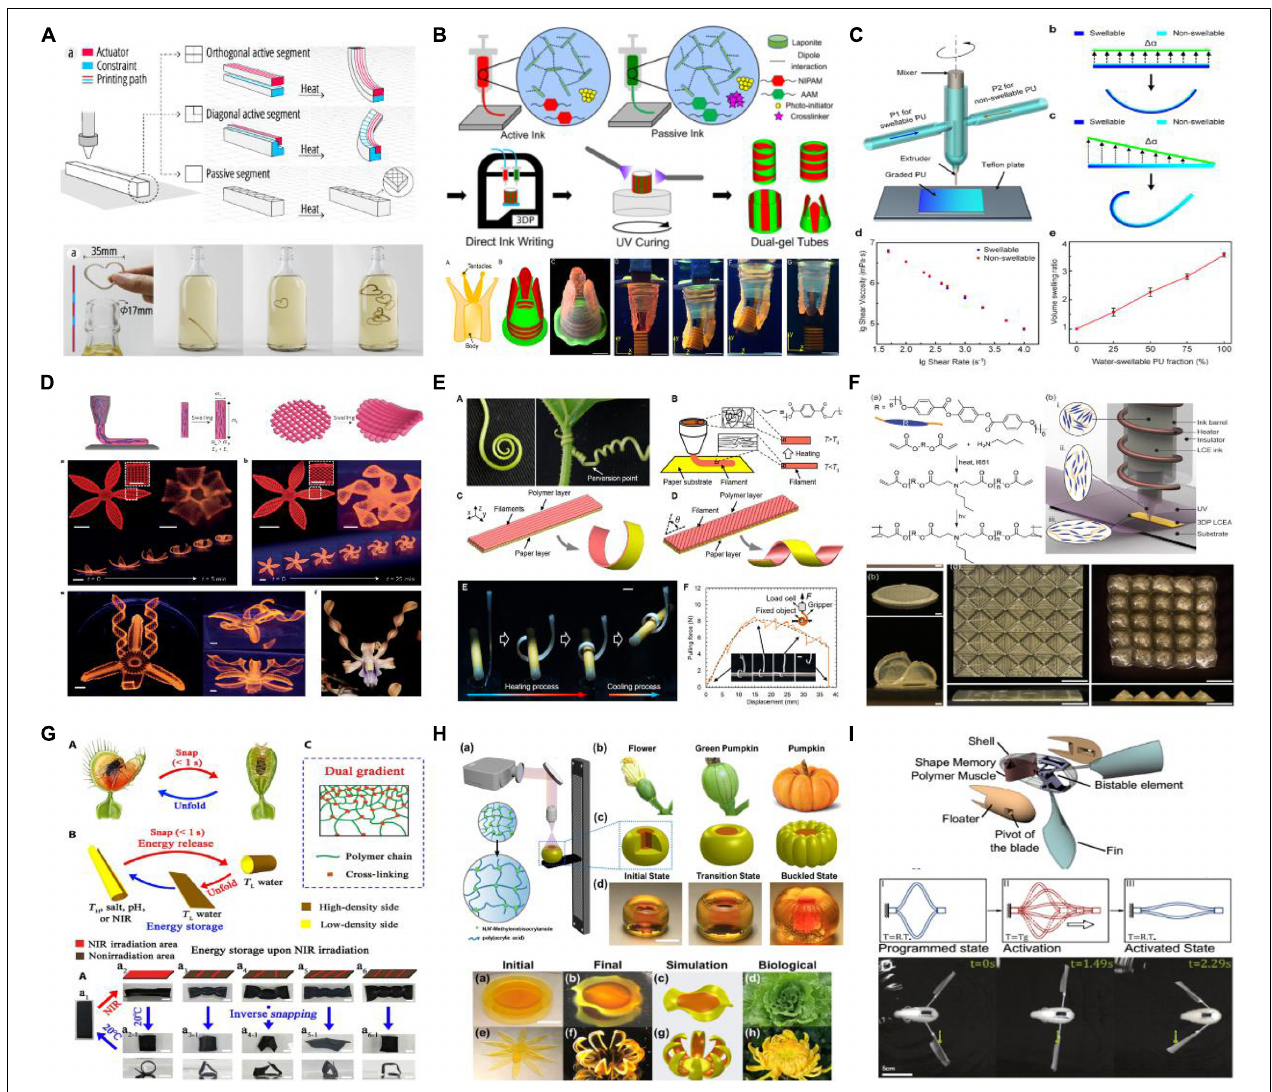
FIGURE 5 | The soft actuators by mimicking the structures of plants in nature. (A) The line-shaped deformable composite structure by arranging the local material with different thermal–mechanical properties. (B) The gel tubes with the ability of gripping by strategic placement of a swelling gel and a nonswelling gel. (C) Dual-stimulated self-deforming structures by printing graded water-responsive materials on the thermal shrinkable shape memory polymers. (D) Localized, anisotropic swelling hydrogel composites by aligning the cellulose fibrils with the inducing force generated in extrusion process. (E) Robotic tendril with anisotropic shape-morphing behaviors by tailoring a polymer–paper bilayer composite sheet with the design of print pattern. (F) Liquid crystal elastomer (LCE) soft actuators with spatially aligned nematic order by programming the print path with the shear force generated in printing process. (G) Rapid response to hydrogel sheet fracture by controlling the magnitude and location of prestored energy in the hydrogel sheet. (H) Buckling core–shell dual-gel structure by employing the buckling instability generated by the mechanical mismatch between the soft shell and the stiff core. (I) Bistable “muscle” propulsion by amplifying displacements with a small incremental